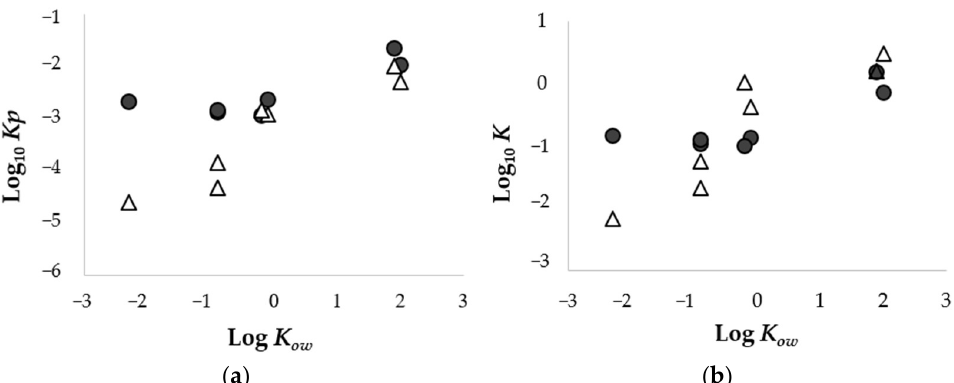
Figure 3. Relationship between the Log K ow and Kp ( a ) or K ( b ) of chemicals applied through porcine skin or Strat-M ® . Circles ( ● ) represent porcine skin and triangles (Δ) represent Strat-M ® ; each point represents the mean ( n = 3−4).